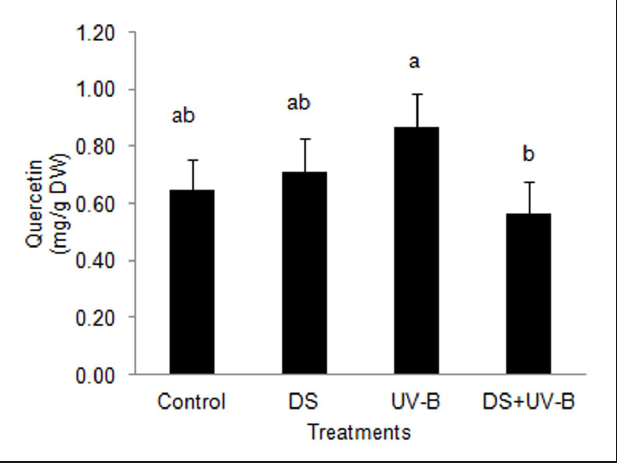
Fig. 5: Quercetin content (mg g -1 DM) of lettuce at harvest in response to drought stress, UV-B radiation and in combination of drought stress and UV-B radiation. Vertical bars represent standard deviation, and different letters indicate differences at the significance level p ≤ 0.05 (Tukey test). (Control = well-watered; DS = drought stress, i.e. water-deficit; UV-B = well-watered with UV-B radiation of 0.11 kJ m -2 ; DS+UV-B = drought stress i.e. water-deficit in combi- nation with UV-B).